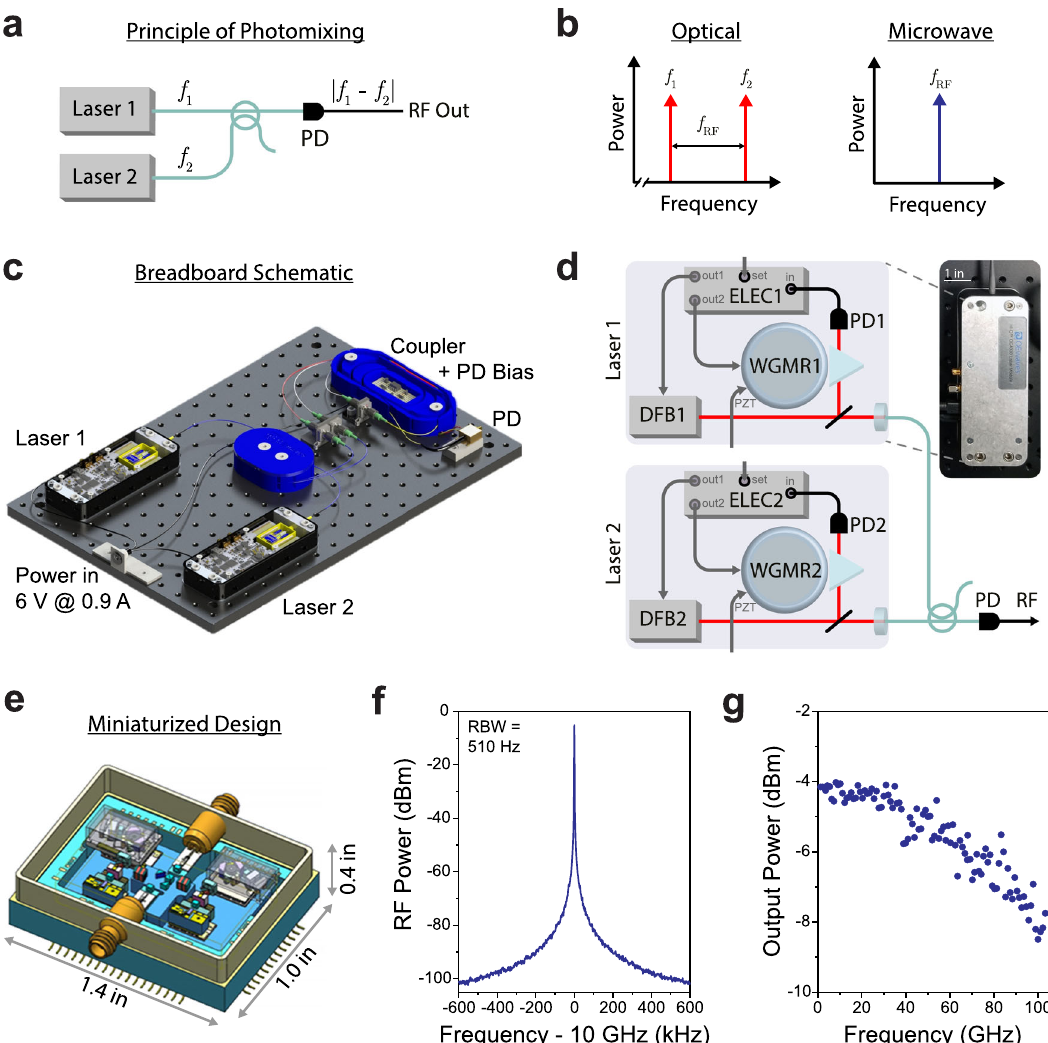
Fig. 1 Microwave and millimeter-wave generation based on heterodyning of self-injection-locked lasers. a diagrams the photomixing (heterodyne) process. Two lasers at optical frequencies f 1 and f 2 are combined on a fast photodiode (PD). The resulting interference beat-note is converted to a RF signal at f RF = ∣ f 1 − f 2 ∣ . The output frequency is varied by tuning of either laser. b depicts this process in the frequency domain for both input optical and output microwave tones. c shows an artistic representation of the heterodyne synthesizer on an optical breadboard. d diagrams the microwave source in greater detail, showing the internal components of the laser oscillators. Each consists of a distributed feedback laser (DFB1; DFB2) that is prism-coupled to a high- fi nesse whispering-gallery-mode microresonator (WGMR1; WGMR2). A small amount of back-re fl ection from the resonator into the laser diode leads to passive self-injection-locking to the resonator modes, and dramatic reduction in laser linewidth, through the external cavity feedback effect. Transmitted light is incident on a photodiode (PD1; PD2) for monitoring, and both the microresonator and laser diode are temperature-controlled by internal control electronics (ELEC1; ELEC2). The laser output frequency is controlled by varying the temperature set-point, and each WGMR can also be strain-tuned by applying an external voltage to a piezoelectric element (PZT). Light from each laser is fi ber-coupled with a collimating lens. The two optical signals are combined via a fi ber coupler on a fast photodiode (PD) for heterodyne synthesis. A photograph of one packaged laser is shown on the right. e shows an illustration of a miniaturized heterodyne synthesizer package under development, consisting of a pair of self-injection-locked lasers, fast photodiodes, and 1.0 mm coaxial outputs. f plots the output microwave spectrum when the oscillator is tuned to f RF = 10 GHz as detected by a radiofrequency spectrum analyzer, with a resolution bandwidth of 510 Hz. g plots the measured output power as the oscillator frequency is varied between 1 and 104 GHz, showing a modest rolloff due to the frequency response of the